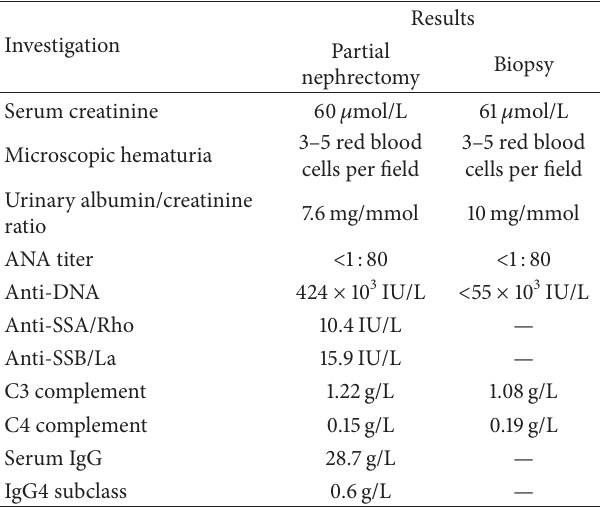
Table 1: Investigation results at time of partial nephrectomy specimen and subsequent kidney biopsy after 12 months of clinical